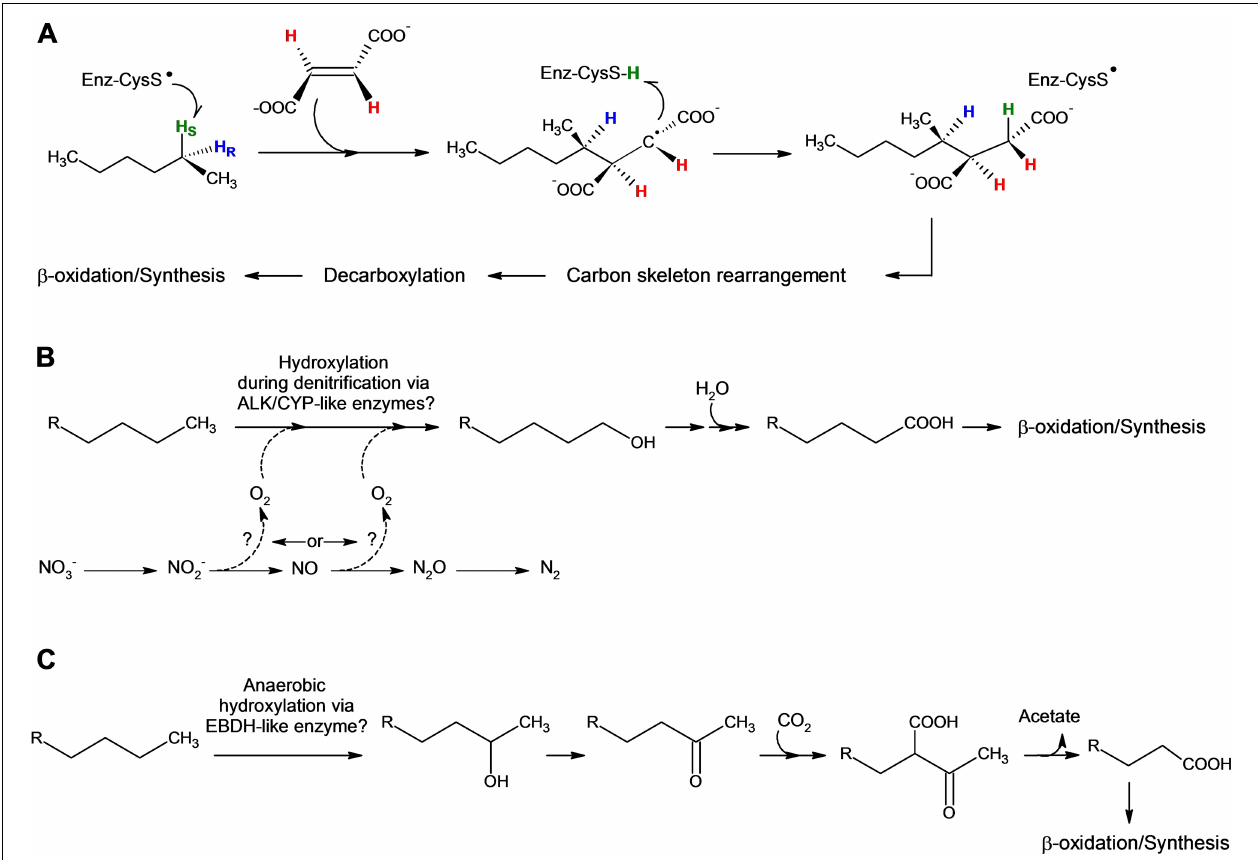
and degradation of non-methane alkanes via anaerobic hydroxylation by Desulfococcus oleovorans Hxd3 (Sünwoldt etal., 2012). Enzyme nomenclature: putative thiyl radical of the alkylsuccinate/methylalkylsuccinate synthase-like enzyme (Enz-CysS); alkane monooxygenase (ALK); cytochromes P450 (CYP); and ethylbenzene dehydrogenase